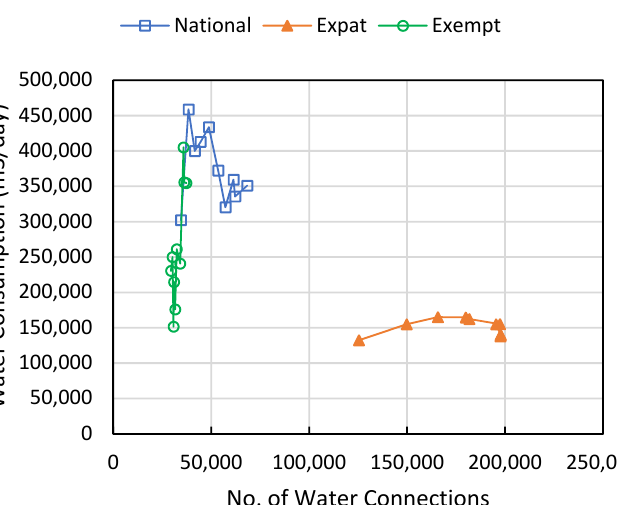
Figure 8. The relationship between water consumption and the number of connections (2010–2019). Note: The exempt water connections were multiplied by 10 to plot in the same graph as the nationals and expats.